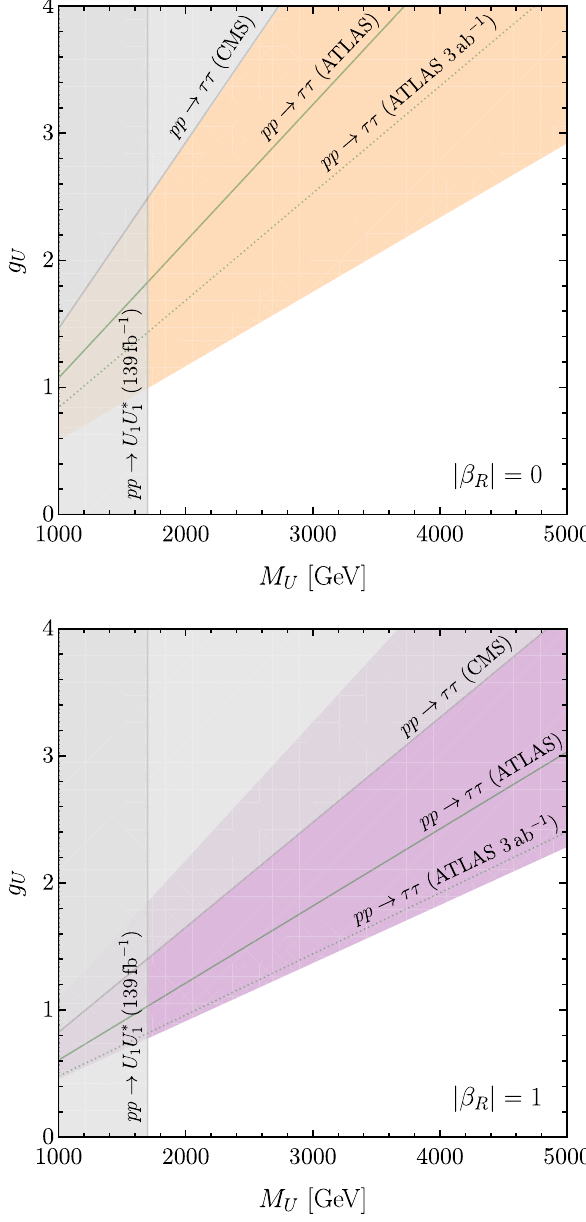
Fig. 4 Preferred region at 90% CL from low-energy charged-current data for mass ( M U ) and leading fermion coupling ( g U ) of the U 1 LQ. Top: Purely left-handed case ( β R = 0). Bottom: Pati-Salam-like case ( | β R | = 1). The gray region and solid lines indicate constraints of present high-energy searches at 95% CL, while the dotted line gives the projected sensitivity at the HL-LHC with a luminosity of 3ab −